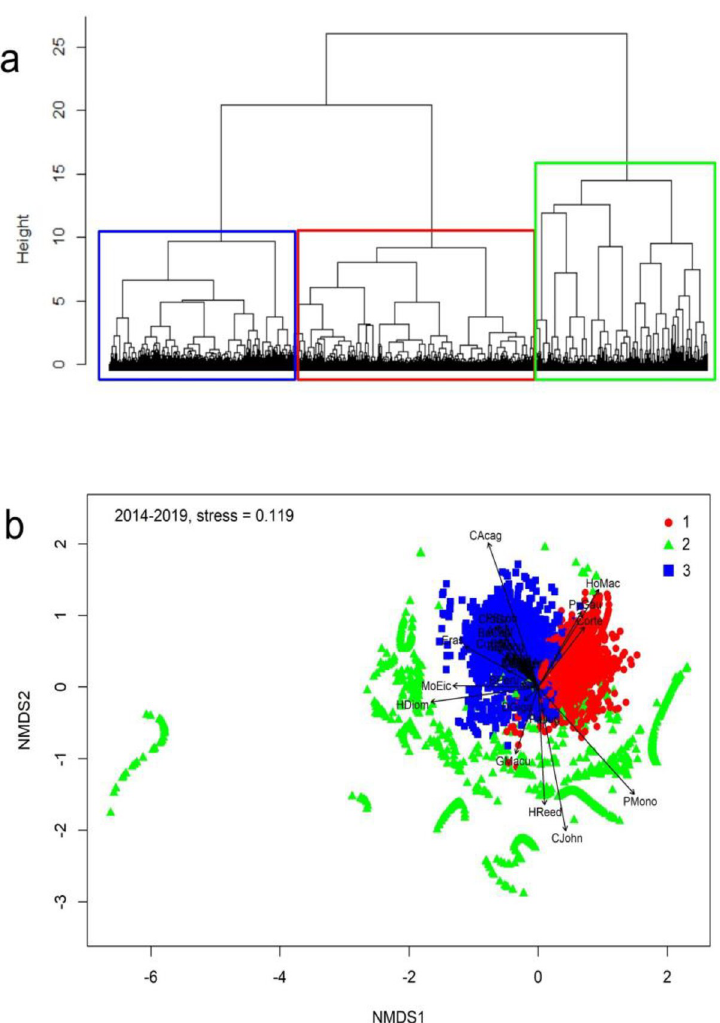
Fig 3. Multivariate analyses, a) beta-flexible clustering analysis and b) non-metric multidimensional scaling (nMDS) of the discarded demersal fauna from the crustacean fisheries operating off central Chile in 2014–2019. Code names are explained in Table